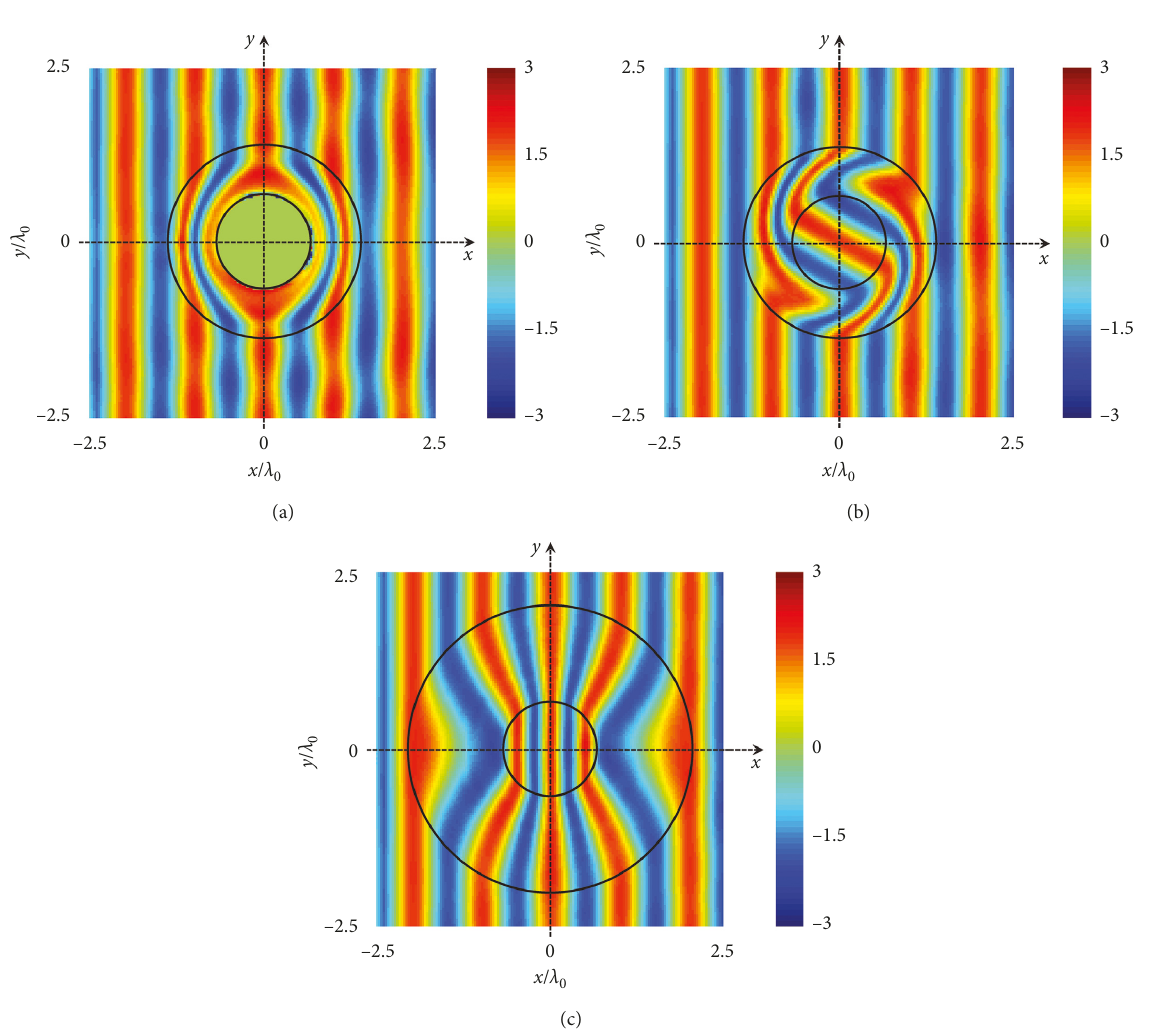
Figure 10: FDTD snapshots with the use of third-order functions: (a) the cloak, (b) the rotator, and (c) the concentrator. The field changed smoothly at the boundaries without